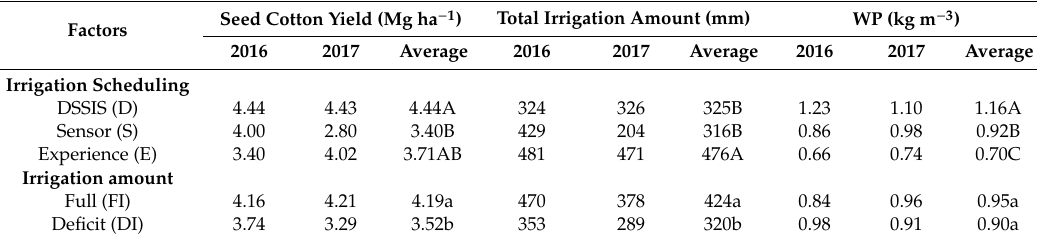
Table 2. Crop yield, total irrigation amount, and WP as a ff ected by two treatment factors.